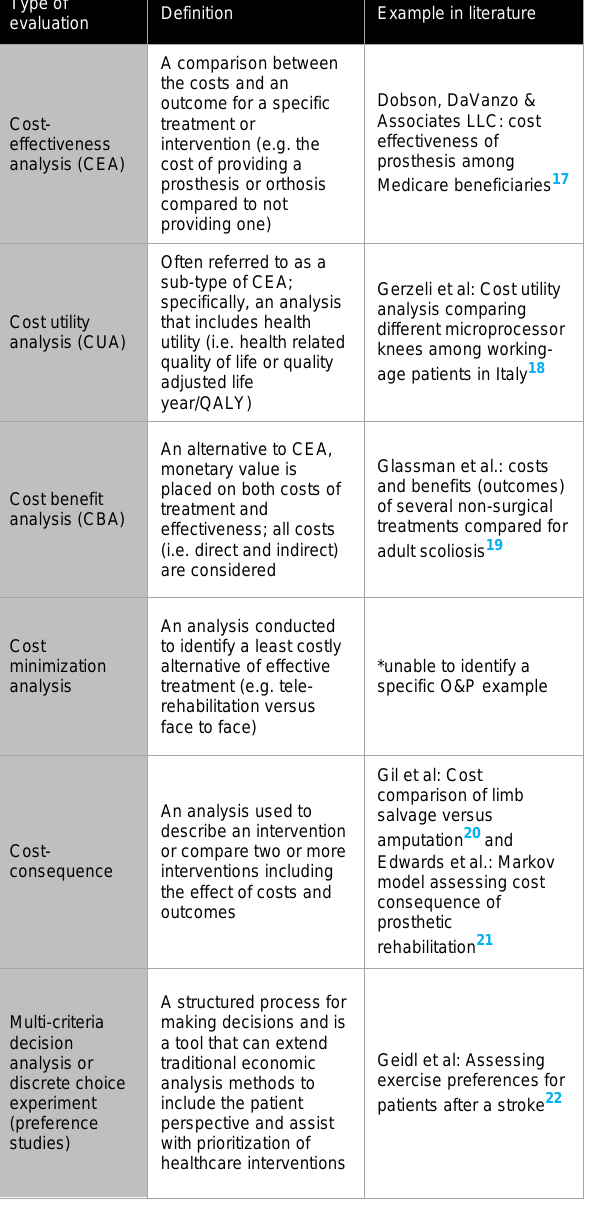
Table 1: Examples of the basic types of economic evaluations and preference-based analyses with applications in O&P or related rehabilitation